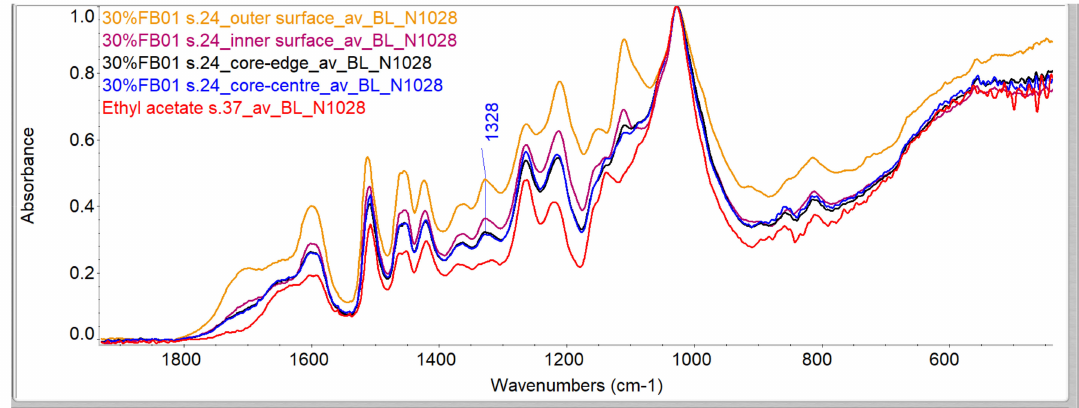
Figure 13. Comparing infrared spectra of 30% FB01-treated specimen 24 from different depths to assess penetration from outside to inner core by measuring band heights at 1328 cm − 1 . The ethyl acetate-treated control (nr. 37) is shown in the red curve. The image shows ‘outer surface’ (orange), ‘inner surface (purple), ‘core edge’ (black) and ‘core centre’ (blue). All spectra were baseline corrected and normalized to 1028 cm − 1 .